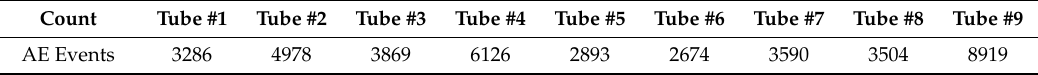
Figure 5. Side-by-side box-plots of each RUS distribution from the test on the 9 tubes. Table 2. Number of acoustic events recorded per tube until tube’s burst.